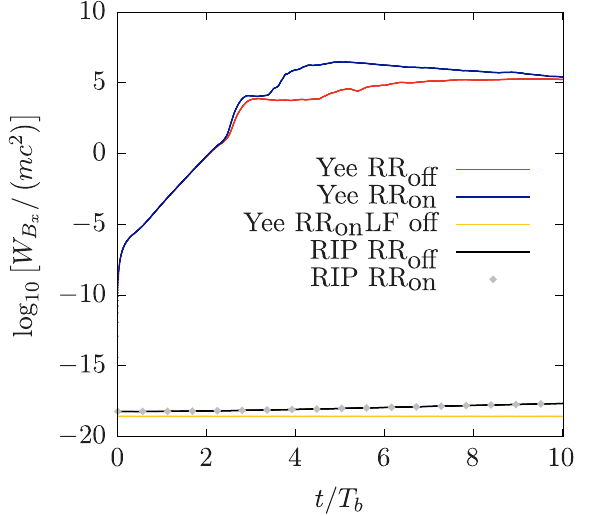
FIG. 5. Longitudinal magnetic field energy evolution for different Maxwell solvers and with or without accounting for RR. Additionally, the yellow line represents the simulation where the fields are updated with the Yee solver and the particles are solely pushed by the RR force; i.e., the momentum change by the Lorentz force (LF) has been ignored.